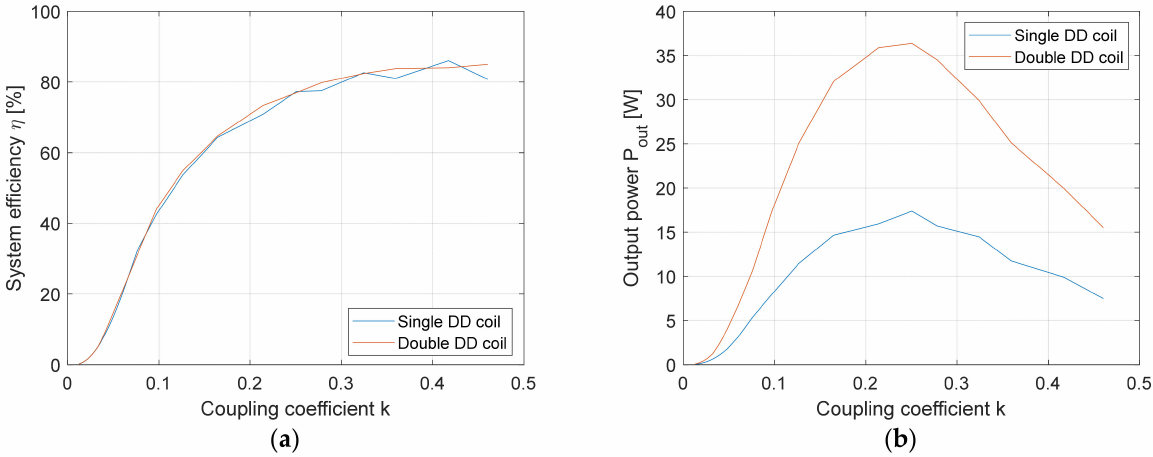
Figure 21. Comparison between the single and double DD coil structures at the frequency 90 kHz: ( a ) system efficiency; ( b ) average output power.